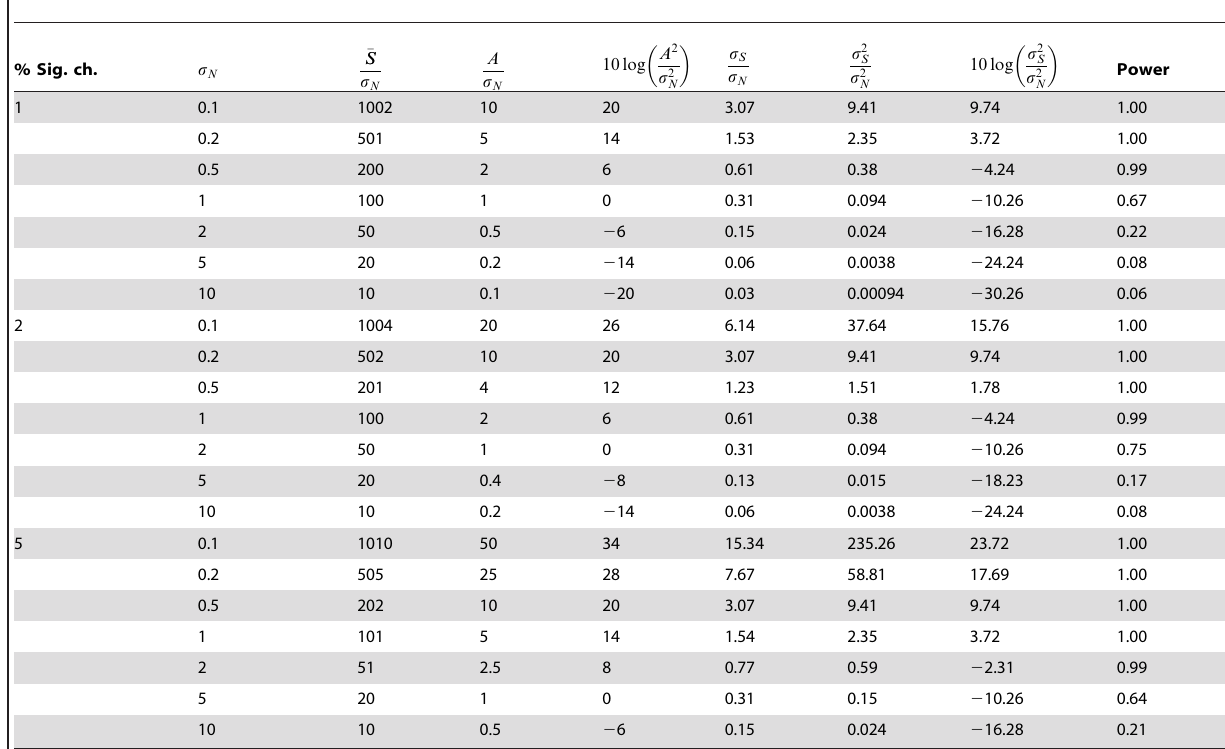
Table 2. Reference table for the different SNR/CNR definitions based on an ER design.